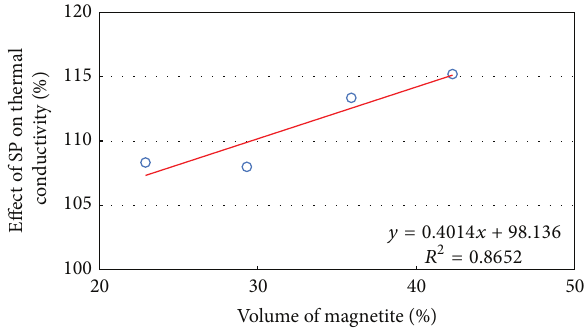
Figure 7: SP effect on thermal